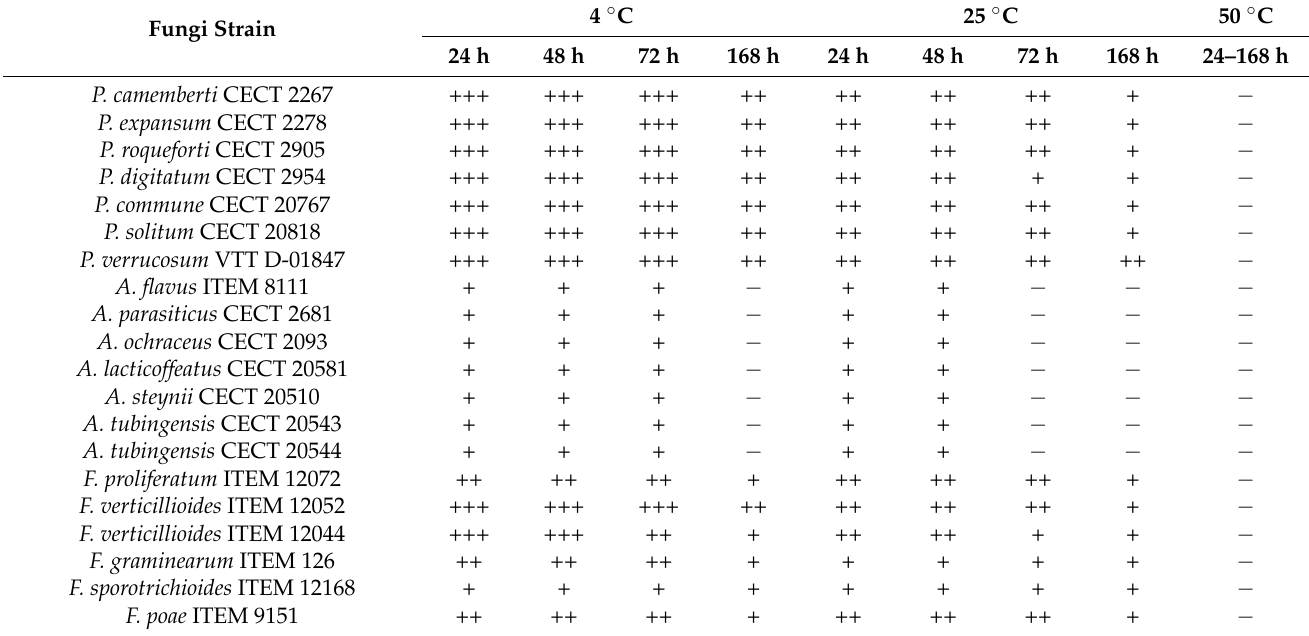
Table 2. White mustard bran (MB) antifungal stability test during storage at different temperatures (4, 25, and 50 ◦ C).